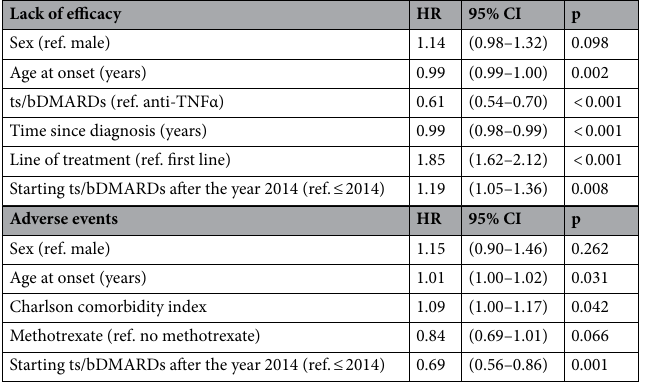
Table 2. Factors associated with treatment discontinuation. Multivariate regression model in the group of patients with rheumatoid arthritis. HR hazard ratio; CI confidence interval.